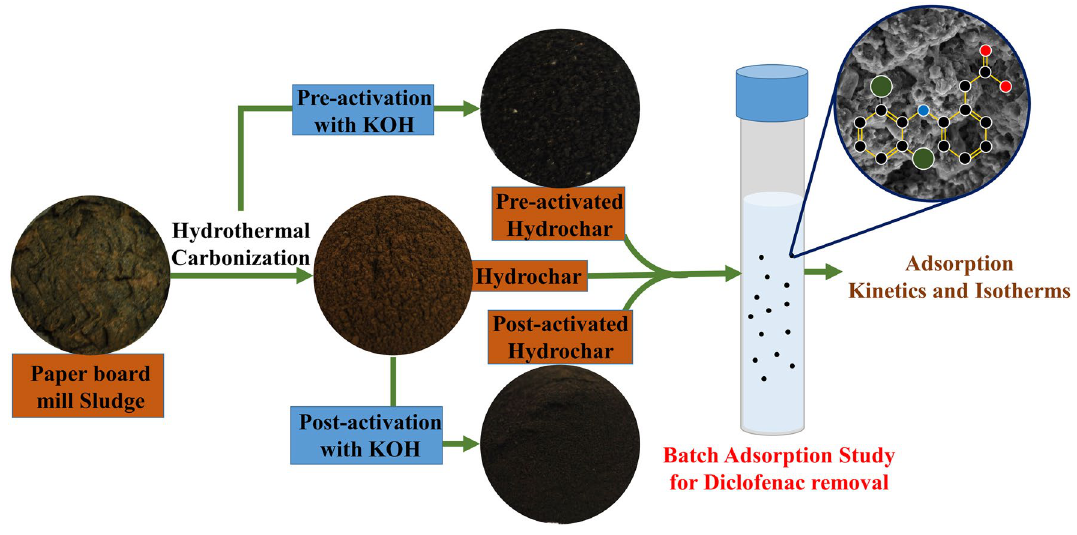
Figure 1. Graphical abstract of the current